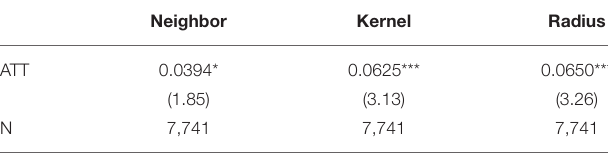
TABLE 4 | PSM regression results. TABLE 5 | Robustness test